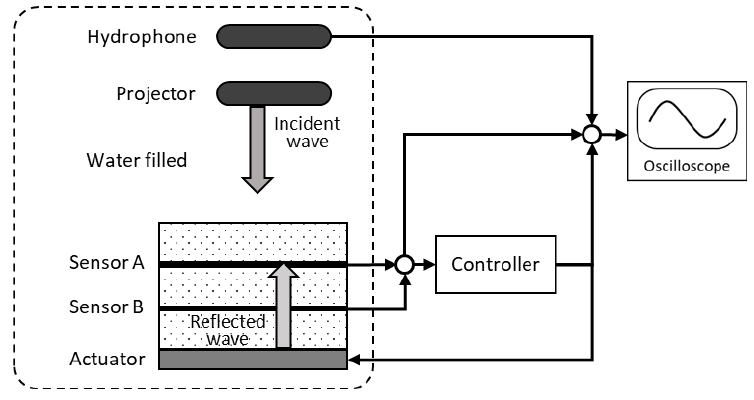
Figure 13. Setup of the echo reduction experiment.